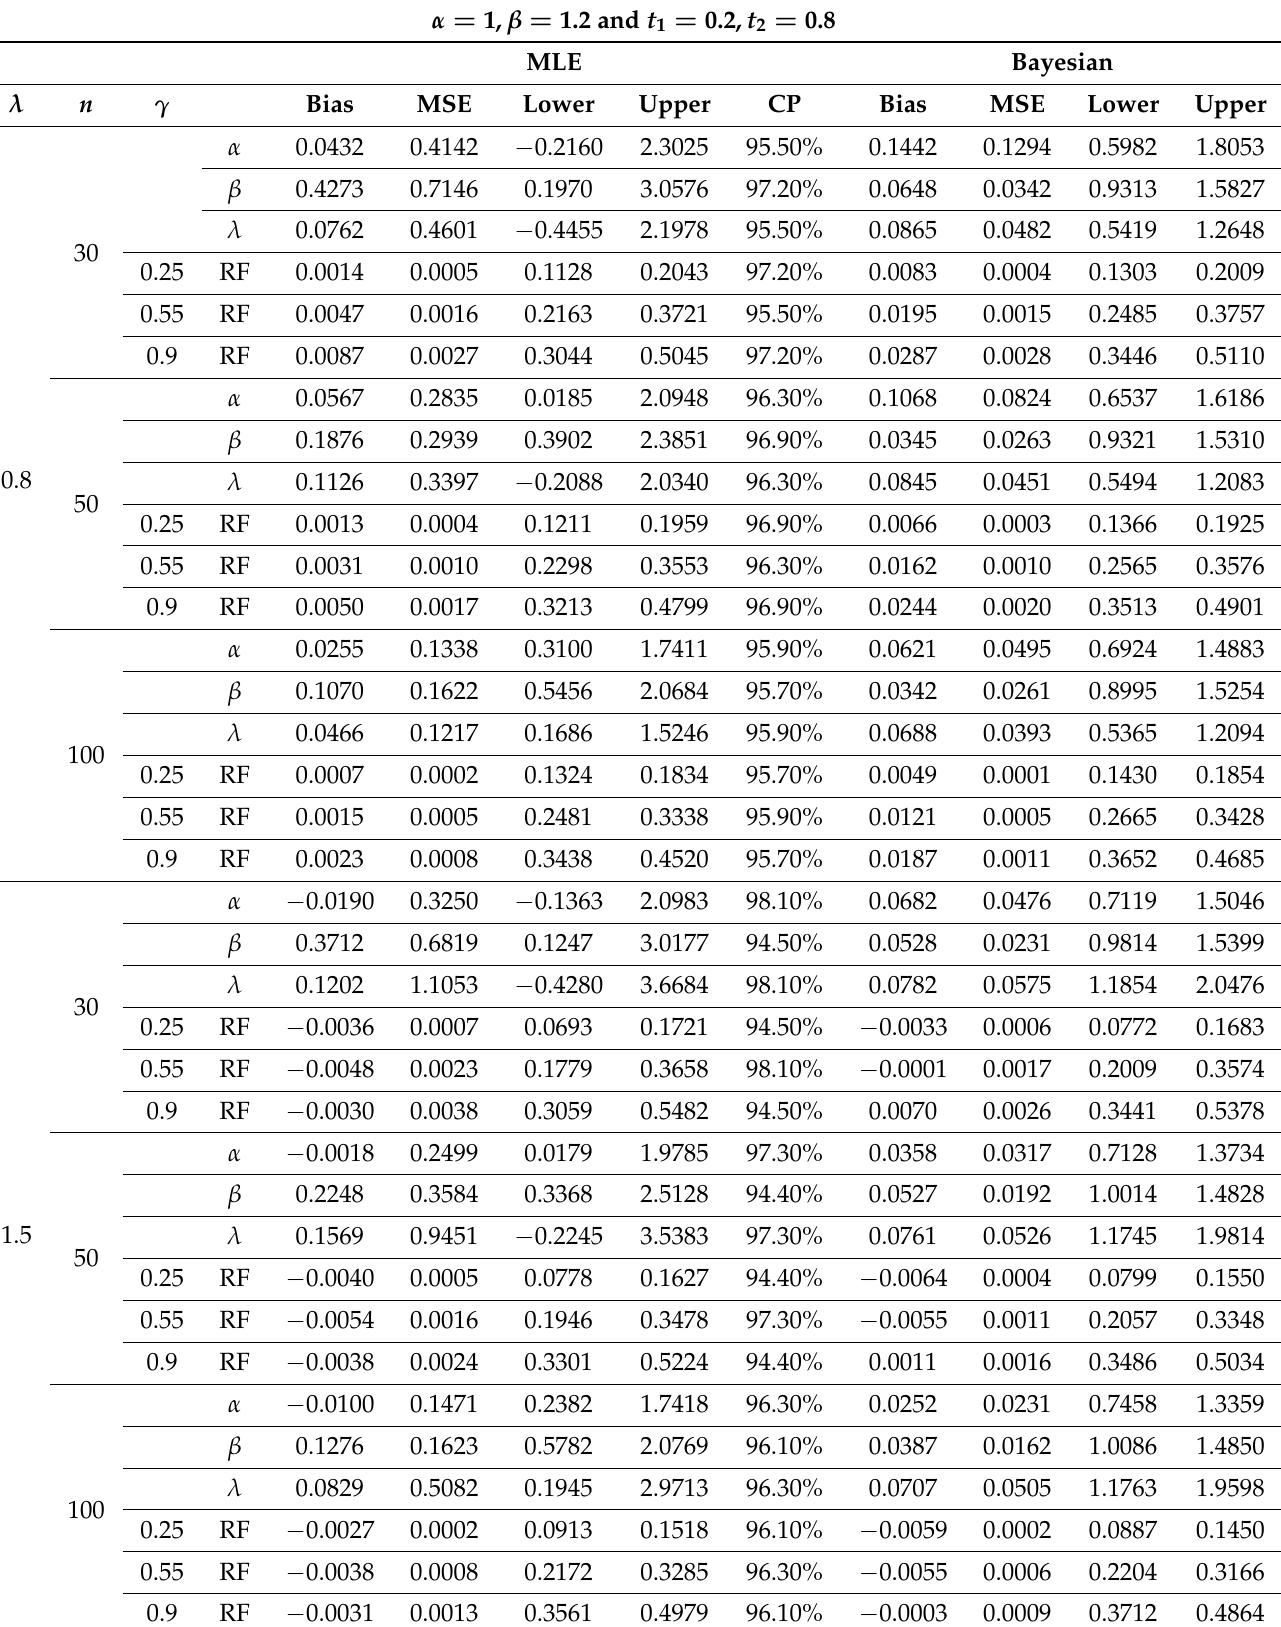
Table 4. Bias, MSE, and CI for fuzzy reliability and parameters of model in case